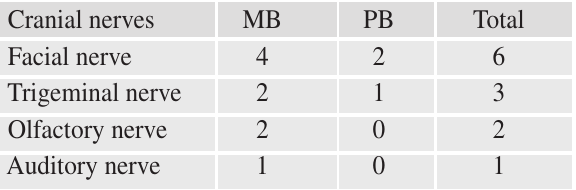
Table V: Cranial nerve involvement in leprosy patients! ! Cranial nerves!